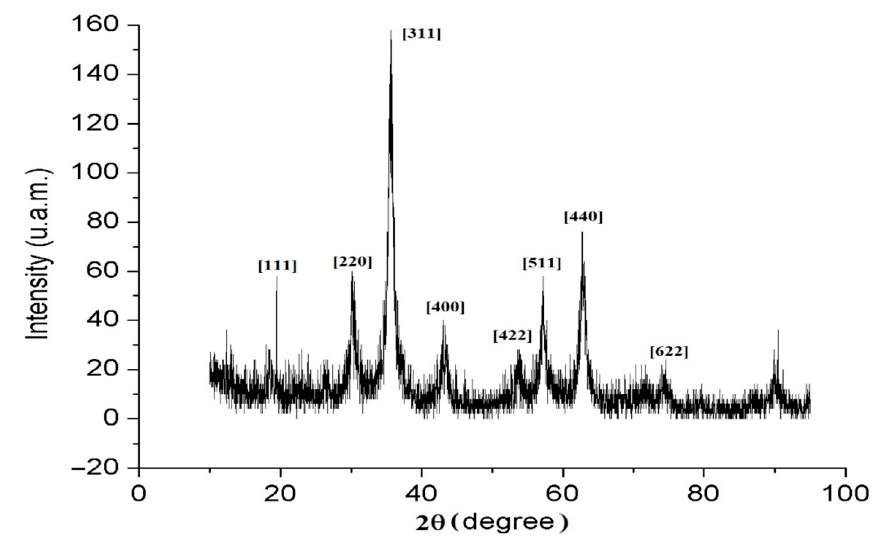
Figure 6. X − ray diffraction pattern of the synthesized A-IONPs.